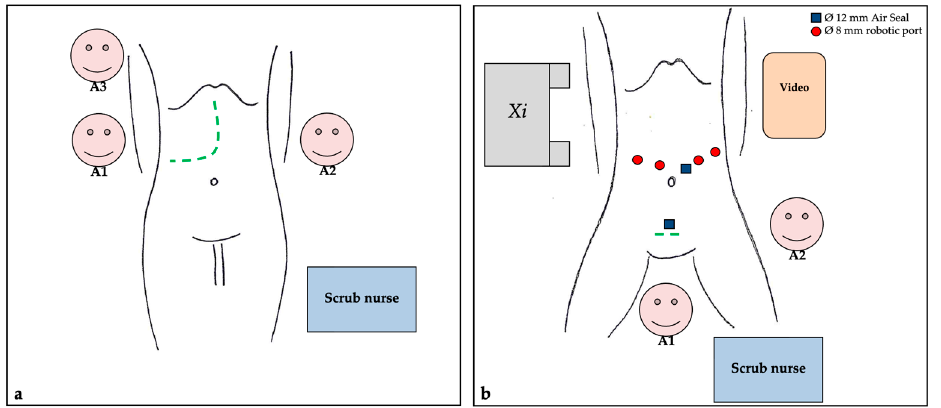
Figure 2. Operative room set-up. ( a ). Open technique. ( b ). Robotic/laparoscopic technique. The hypogastric trocar is used for the Pringle maneuver.